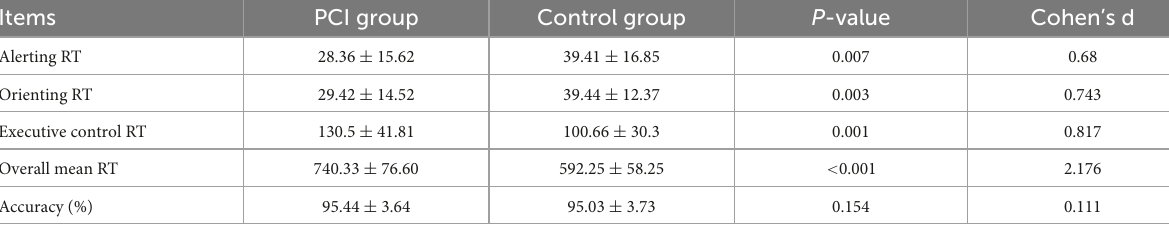
TABLE 2 Comparison of attention network function between controls and patients with posterior circulation ischemia.